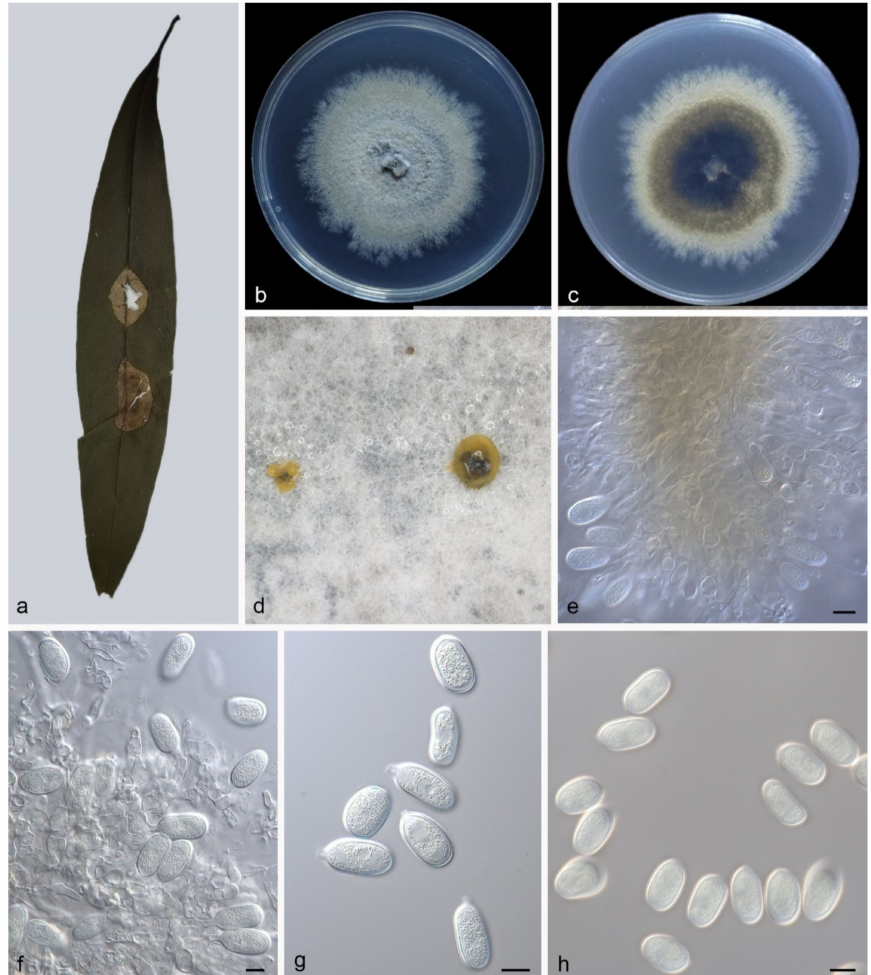
Figure 7. Pseudoplagiostoma machili (holotype HMAS 352299). ( a ) leaves of host plant; ( b , c )